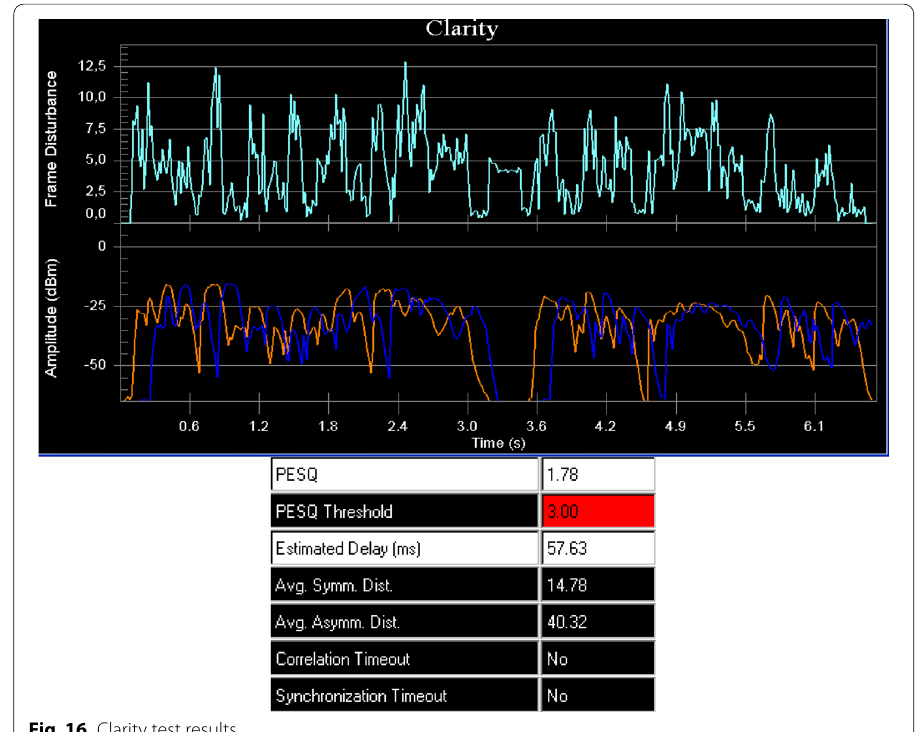
Fig. 16 Clarity test results